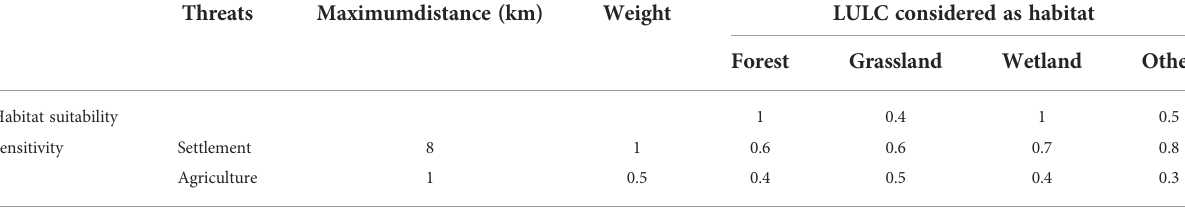
TABLE 1 The important date used to Input habitat quality